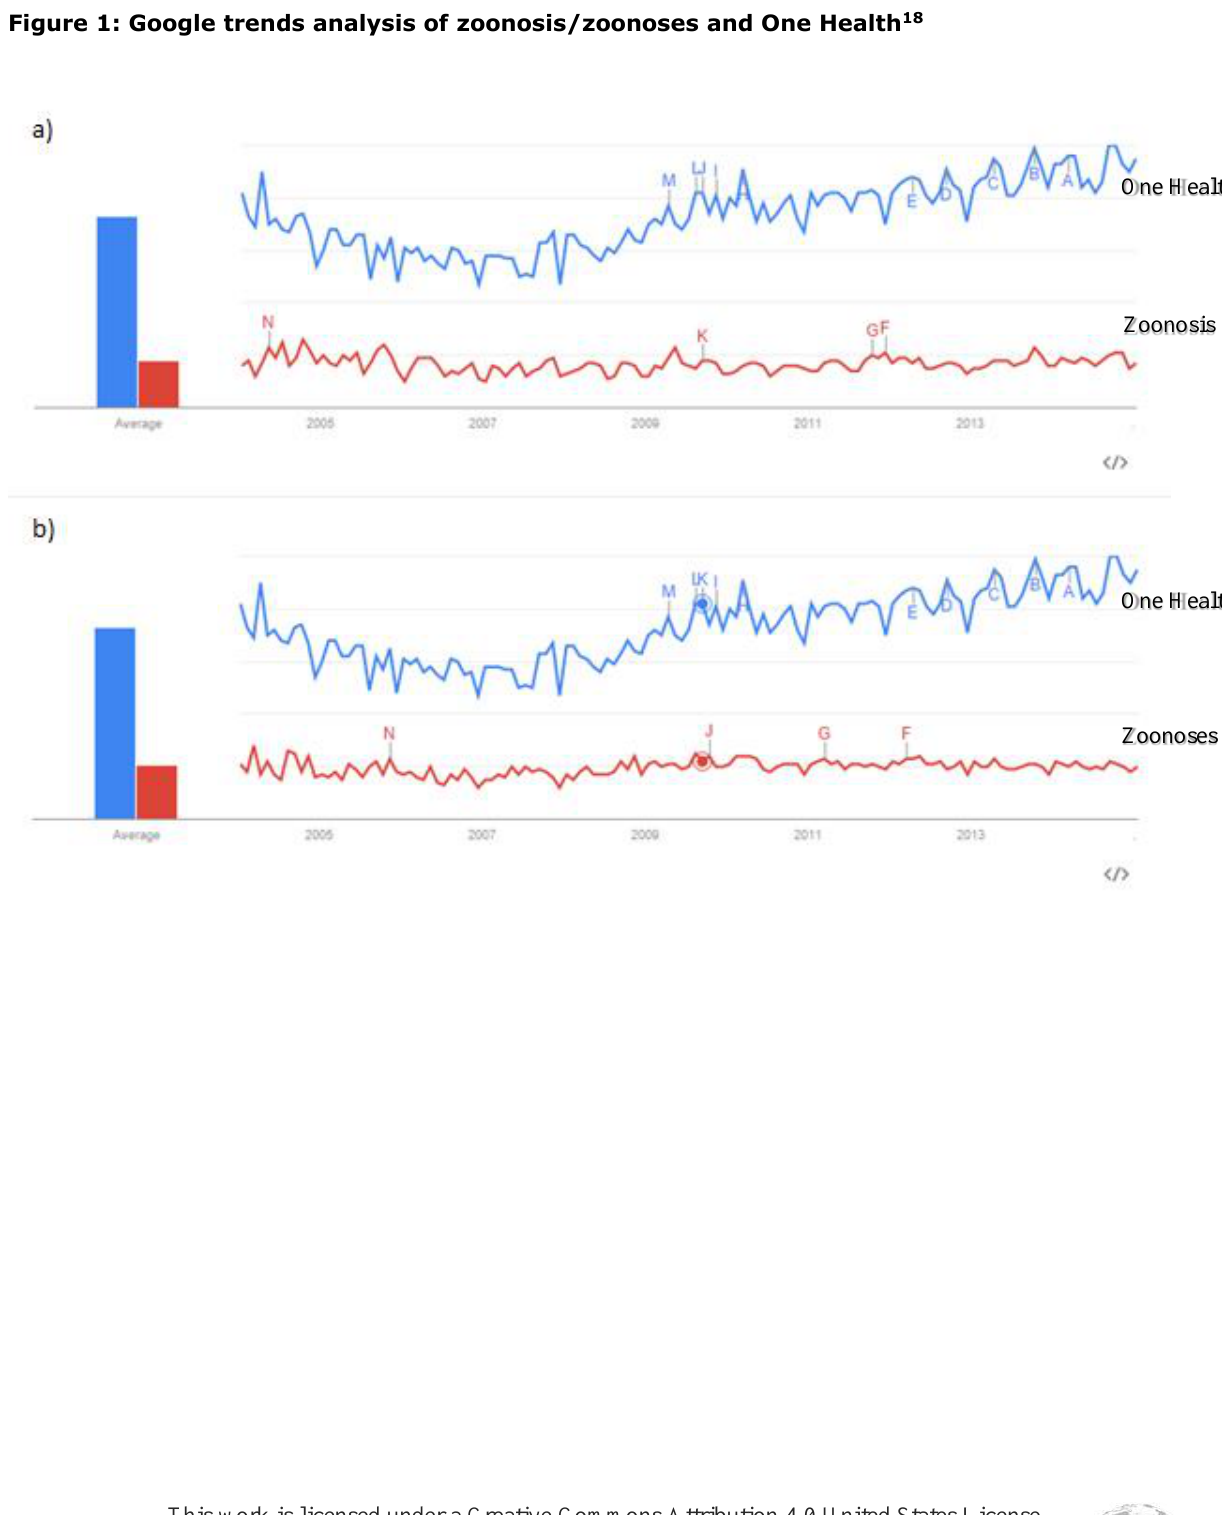
Figure 1: Google trends analysis of zoonosis/zoonoses and One Health 18